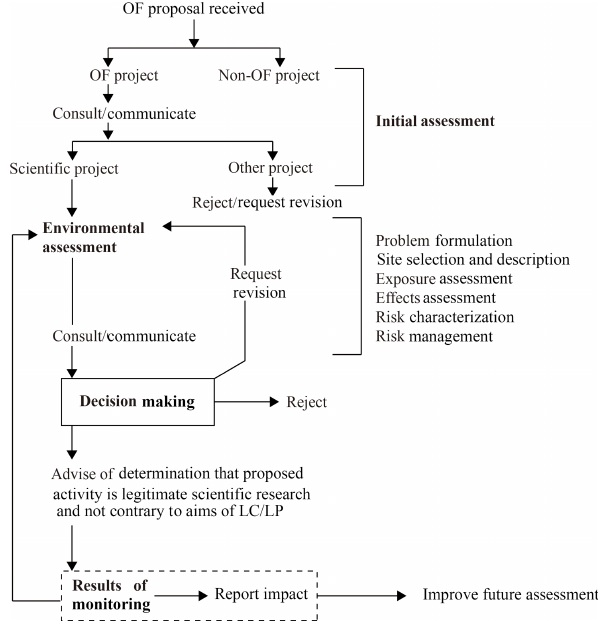
Figure 9. Assessment framework for scientific research involving ocean fertilization (OF) (modified from Resolution LC-LP.2,